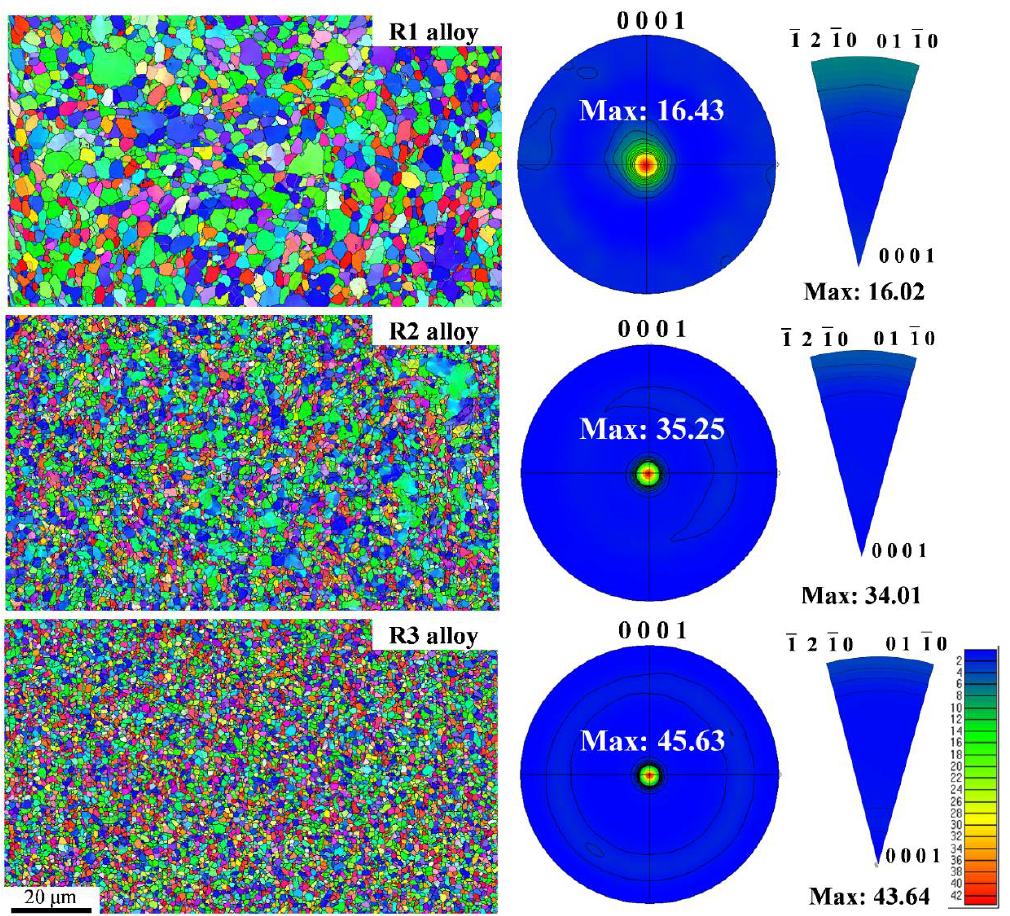
Figure 4. Microstructure, the (0001) pole figures (PFs), and IPF evolution at the cross-section of alloys.